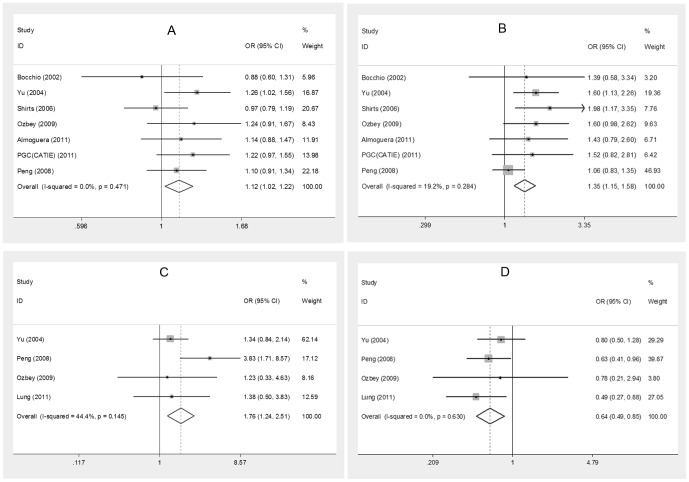
Forest plots of pooled odds ratios in meta-analysis.
A. Allele A vs. allele C (rs1800872). B. AA vs. AC+CC (rs1800872). C. Haplotype A-C-A (Asian samples). D. Haplotype G-C-C (Asian samples).